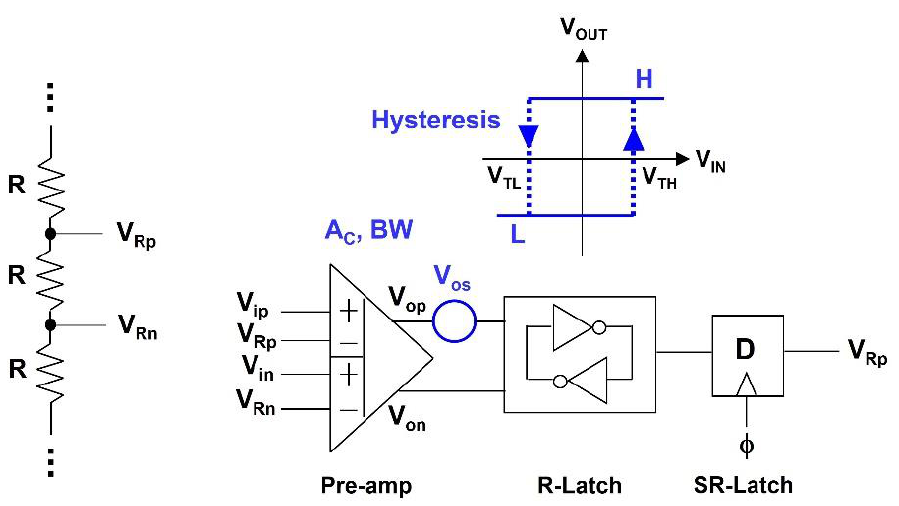
Figure 4. Concept of comparator macro model.